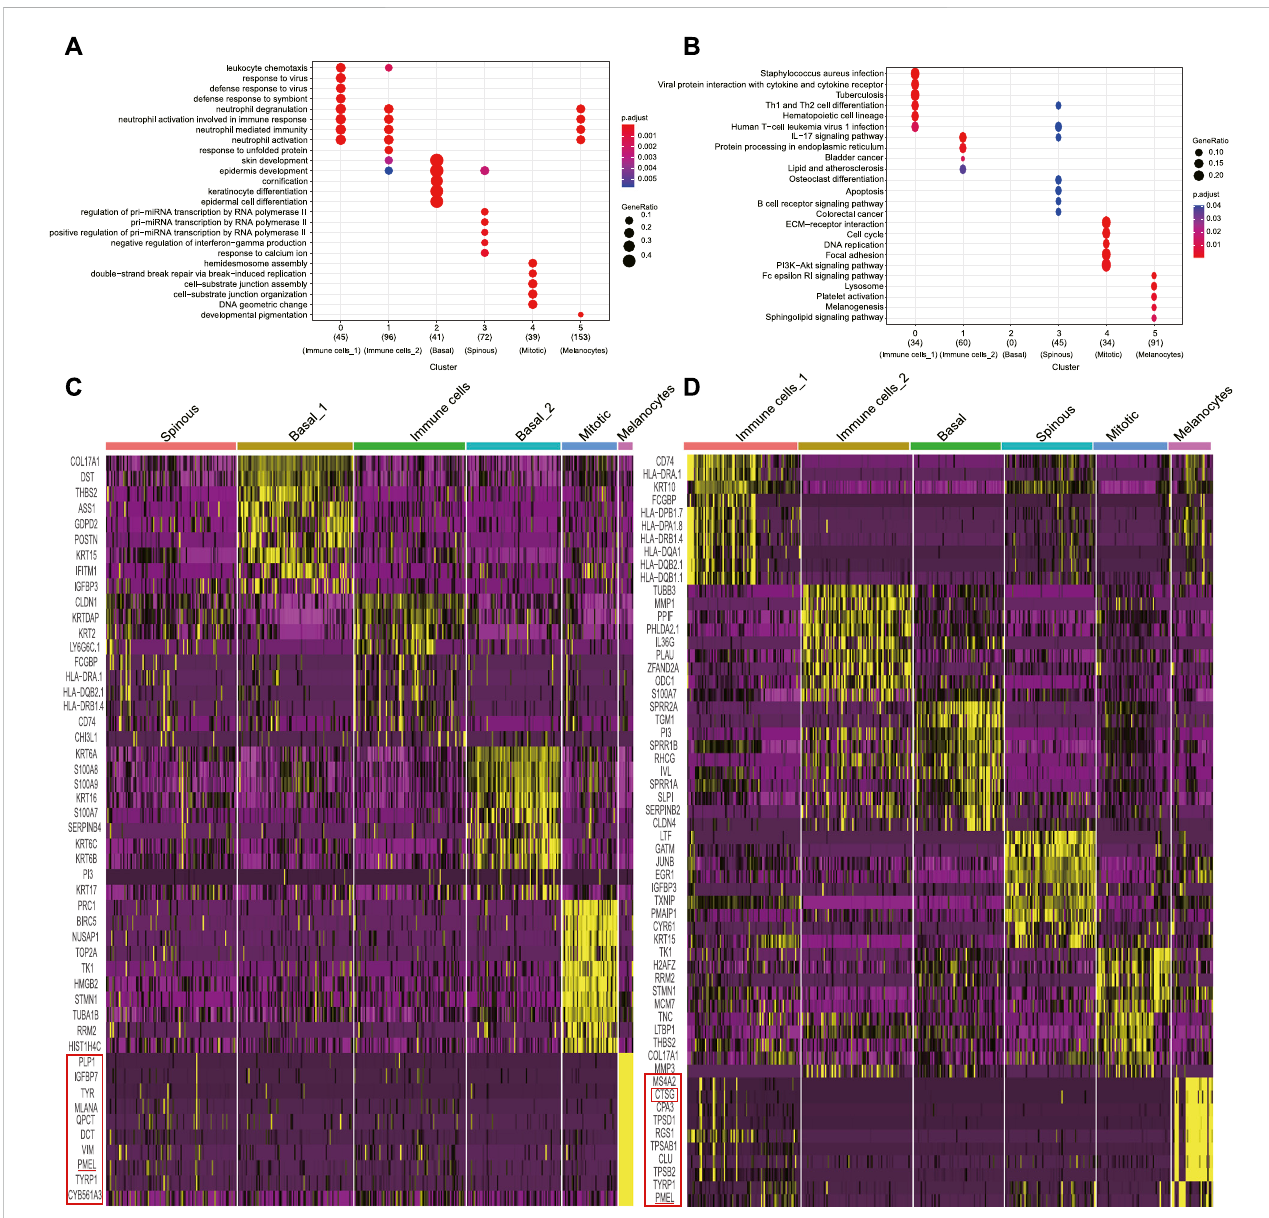
FIGURE 1 Classi fi cationofuninjuredskinandwoundepidermalcellconstitution. (A) ,GOanalysesofeachclusterforclusterannotationinPU. (B) ,KEGGanalysesof eachclusterforclusterannotationinPU. (C) ,Heatmapofeachcellpopulation ’ stop10genes ’ expressiontoothercellpopulations(yellow)inAW,somegenes arenotshown. (D) ,Heatmapofeachcellpopulation ’ stop10genes ’ expressiontoothercellpopulations(yellow)inPU,somegenesarenotshown.AW:acute wounds; PU: pressure